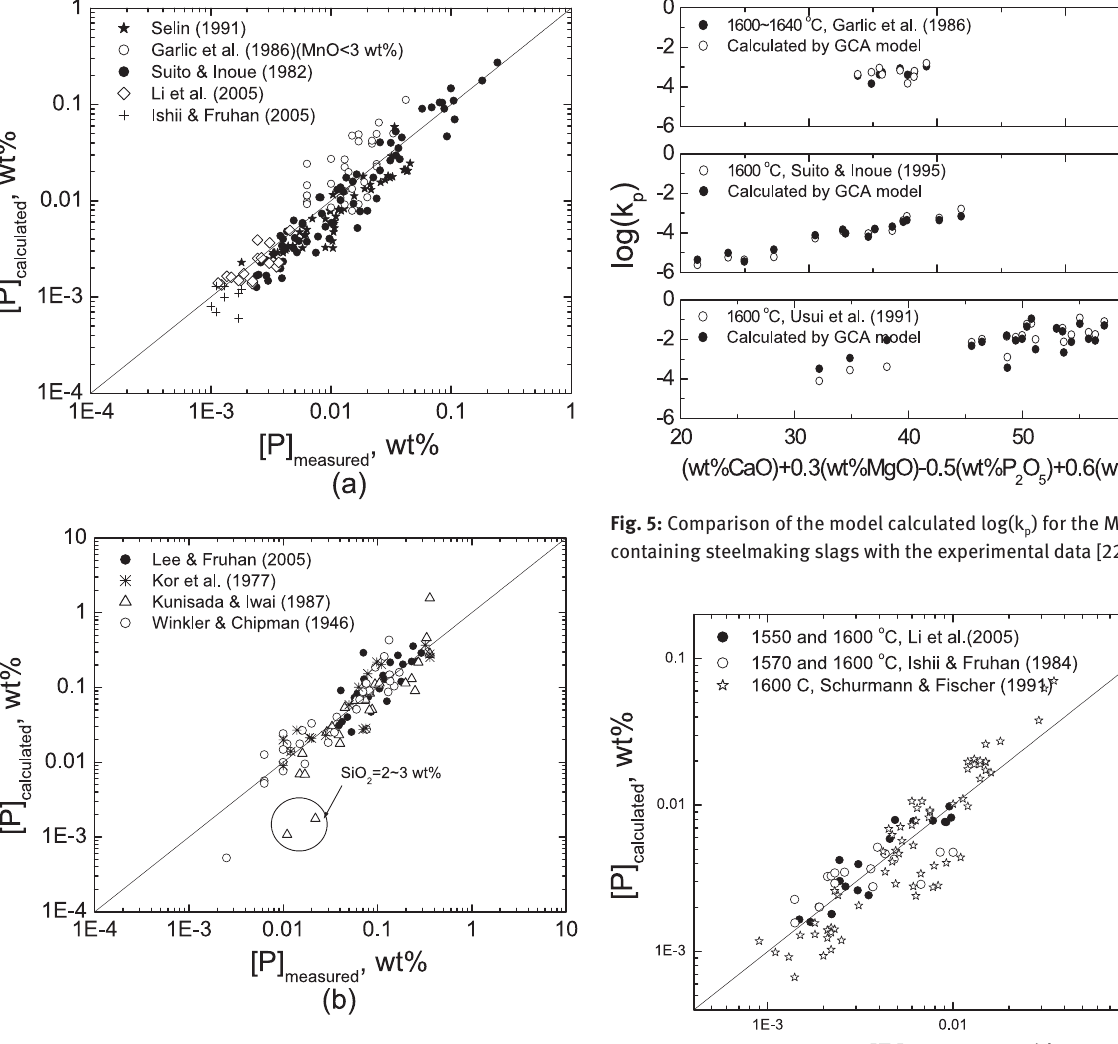
Fig. 4: Comparison of the P solubility in liquid iron calculated by GCA model with the experimental data [14–18, 20, 22, 24, 27, 33, 34]. orders of magnitude variation. Figure 4b also shows that current model parameters cause relatively large devia- tion on the P distribution for the slag with low SiO centration.